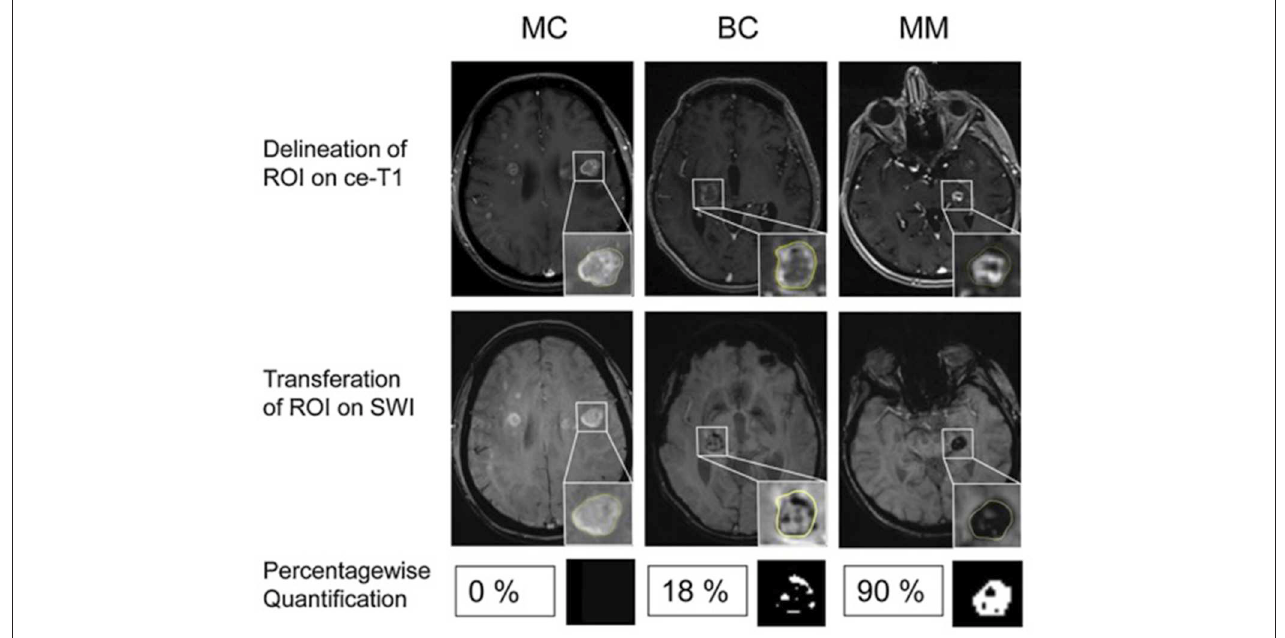
FIGURE 1 | Differentiation of brain metastases by ITSS. Examples of patients with MC, BC and MM. (Upper) Contrast enhanced T1-weighted images (ce-T1). (Middle) Contrast enhanced susceptibility weighted images (SWI). Insets: Delineation of the enhancing lesion on ce-T1 images and corresponding ROI on SWI. (Lower) Percentagewise ITSS quantification with corresponding binarized ITSS map. No ITSS (0%) in MC, minor ITSS (18%) in BC and subtotal ITSS (90%) in MM. Adapted from Radbruch et al.